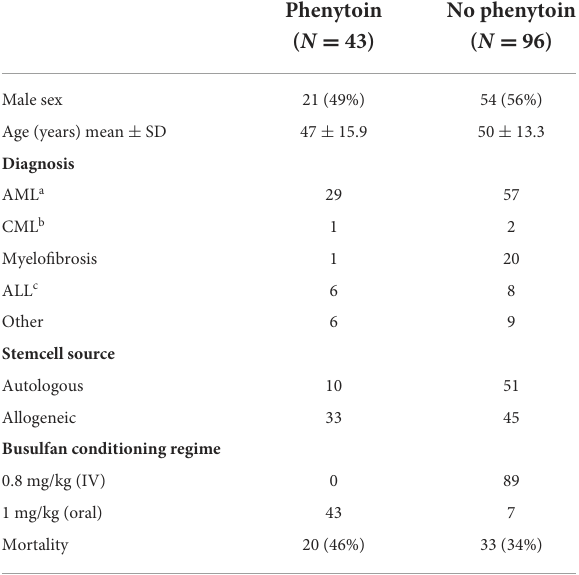
TABLE 1 Patient characteristics.